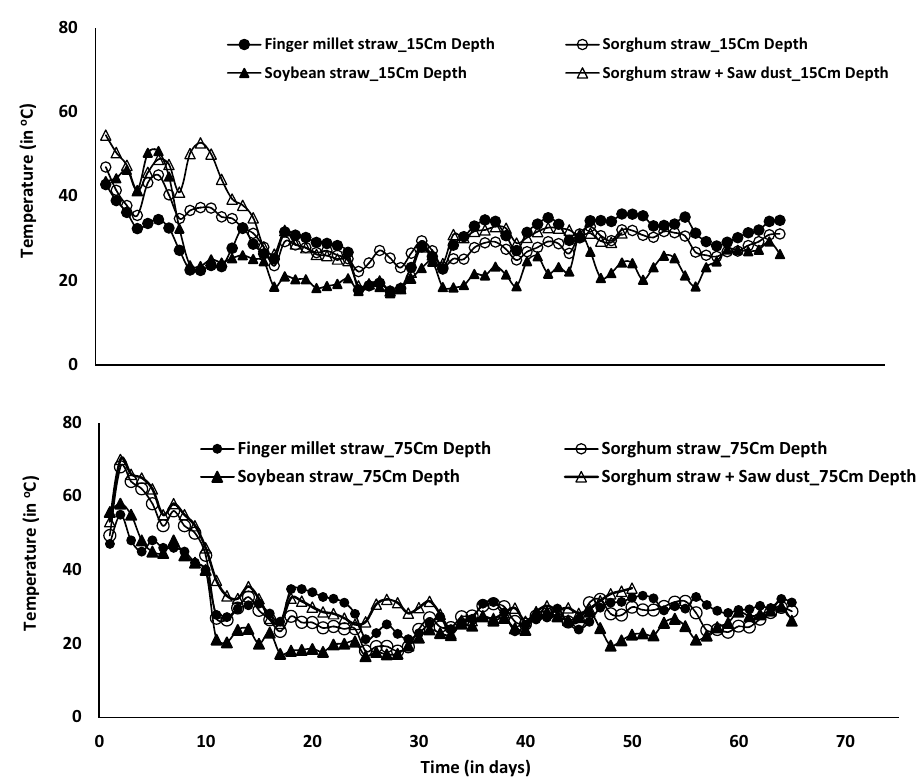
Fig. 2 Temperature profiles recorded for sorghum straw, finger millet straw, soybean straw and sorghum straw + saw dust during composting process in the PVC